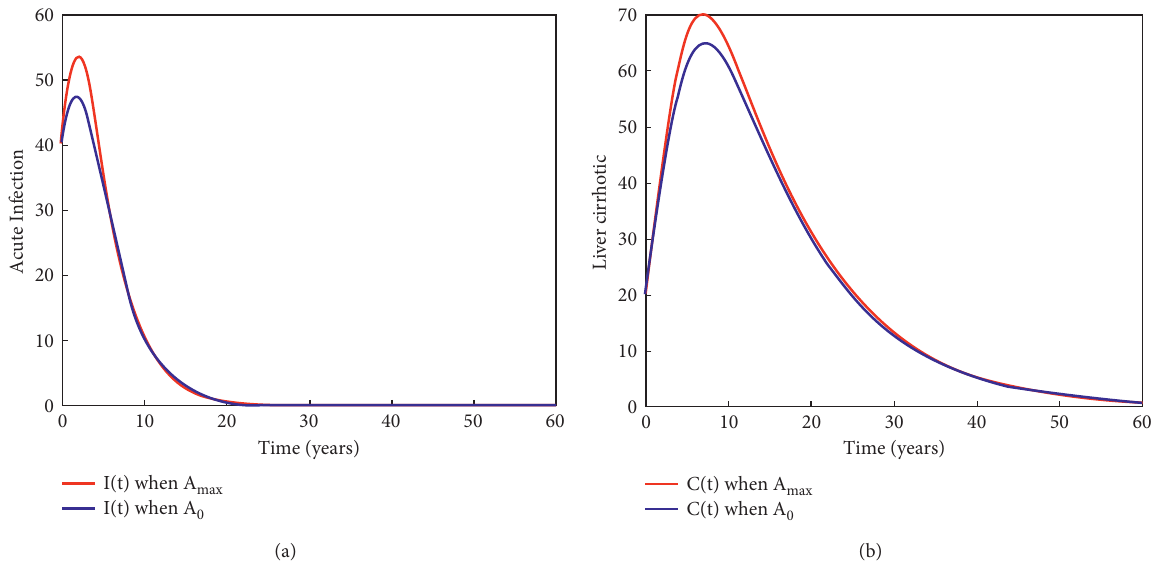
Figure 5: The plots demonstrate the simulation results of I ( t ) and C ( t )